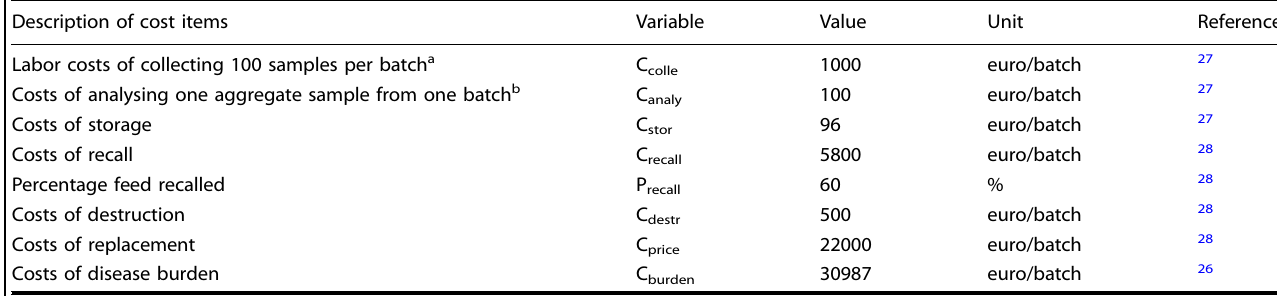
Table 7. Included cost items in the monitoring cost